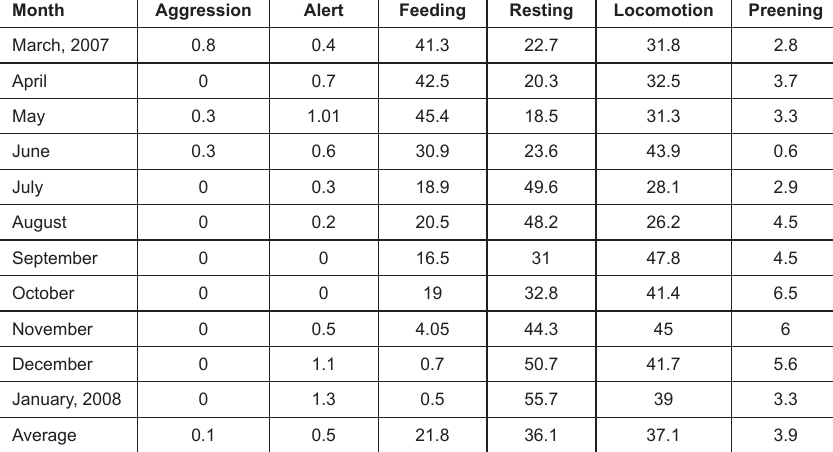
Table 1. Diurnal time activity budgets (%) in Large Whistling Teal in different